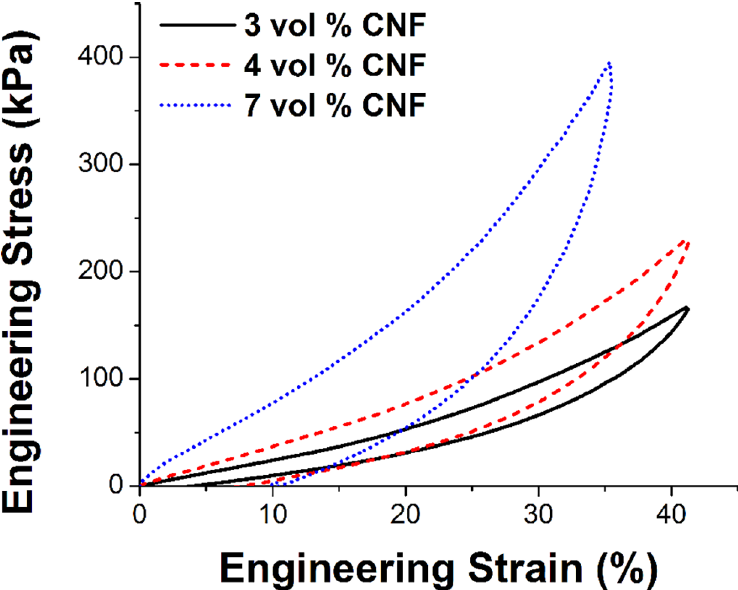
Fig 3. Compressive stress-strain curves for electrode filler loadings of 3, 4 and 7 vol % carbon nanofiber in PDMS.